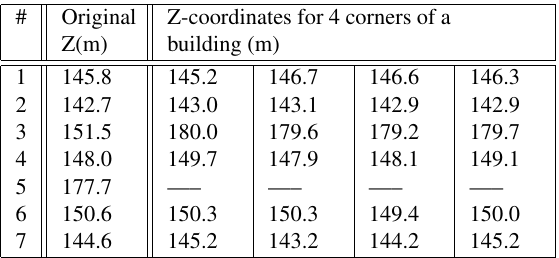
Table 1: Comparison of Z-coordinate results without correlation step for set of buildings (Figure 5)